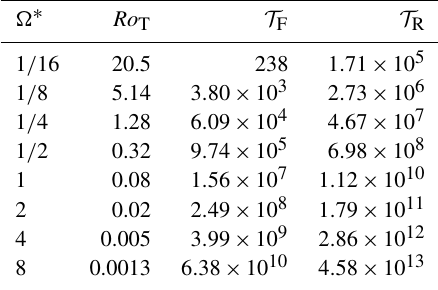
Table 1. Key dimensionless parameters for the baseline set of numerical simulations with (cid:49)θ EP = 60K, τ ft = 5 Earth days and τ R = 25 . 9 Earth days, as defined by Eqs. (13) and